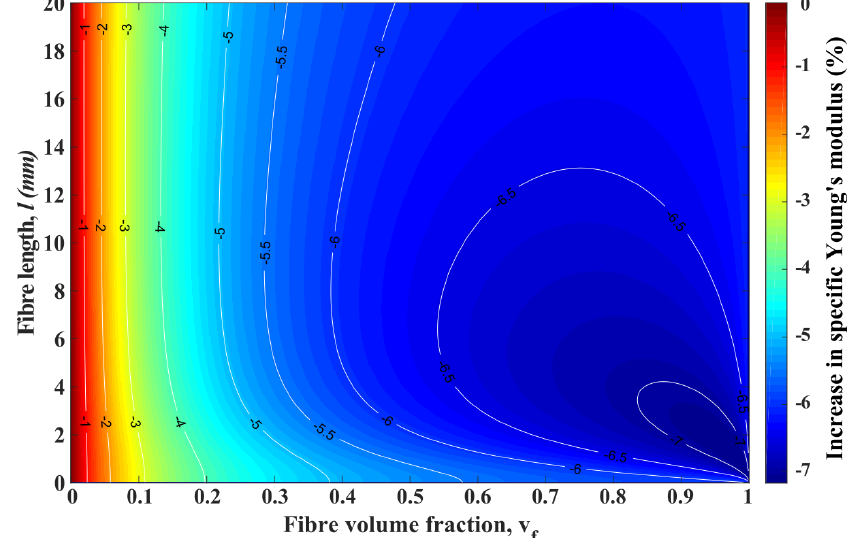
Figure 9. Contour plot of the increase in specific Young’s modulus, when highly aligned discontinuous glass fibre composites are switched to highly aligned discontinuous curaua fibre composites, in terms of fibre volume fraction and fibre length. White isolines are scaled by the right hand colour